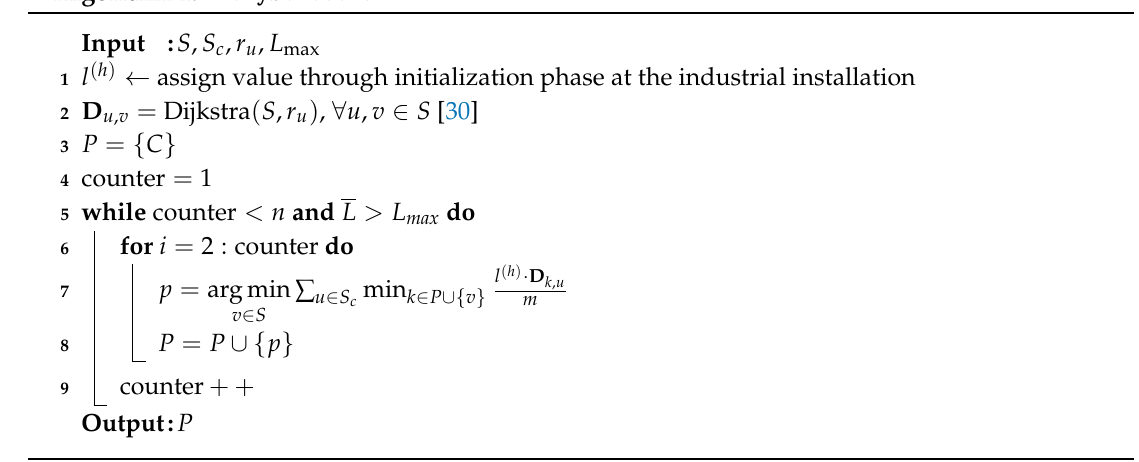
Algorithm 1: ProxySelection+